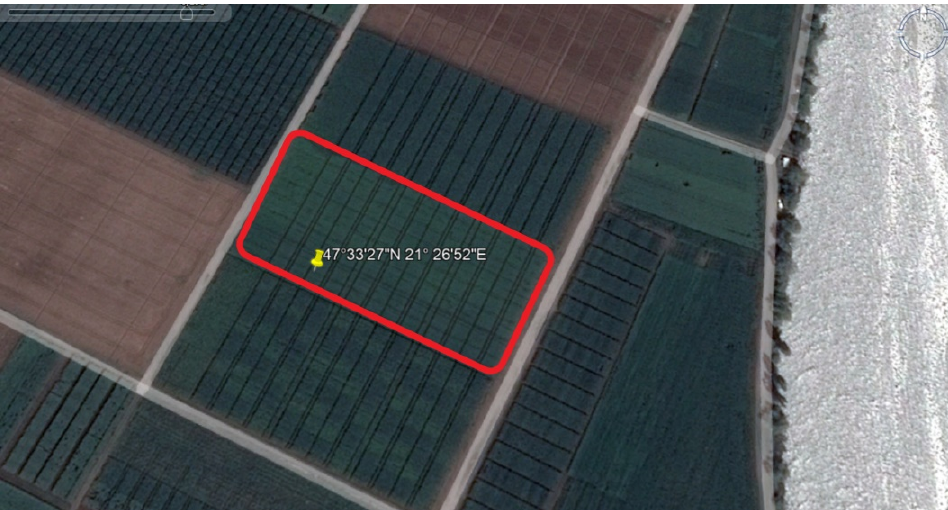
Figure 1. The experimental design in Látókép.